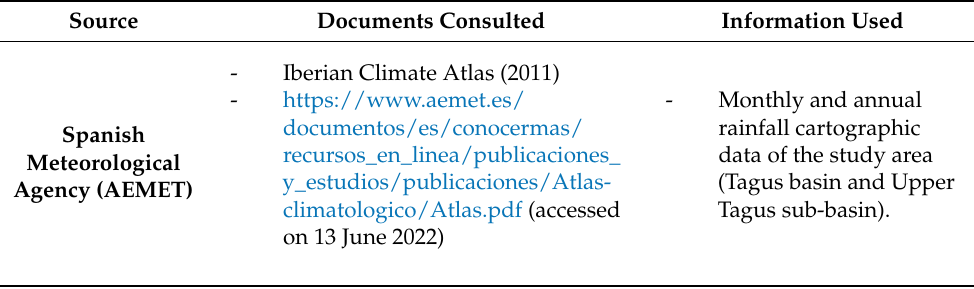
Table 1. Sources and official documents